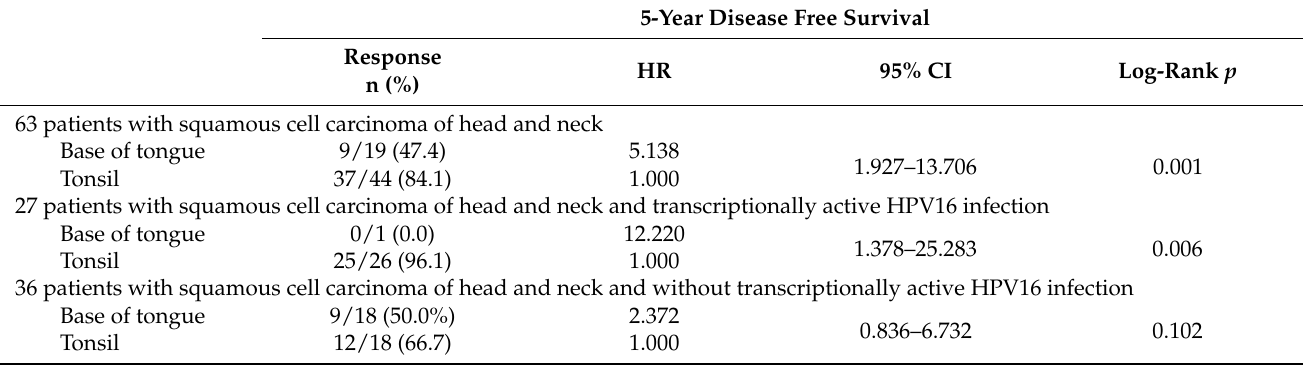
Table 2. 5-year disease-free survival in the group of 63 patients with squamous cell carcinoma of the head and neck and subgroup of 27 patients with transcriptionally active HPV16 infection according to tumor